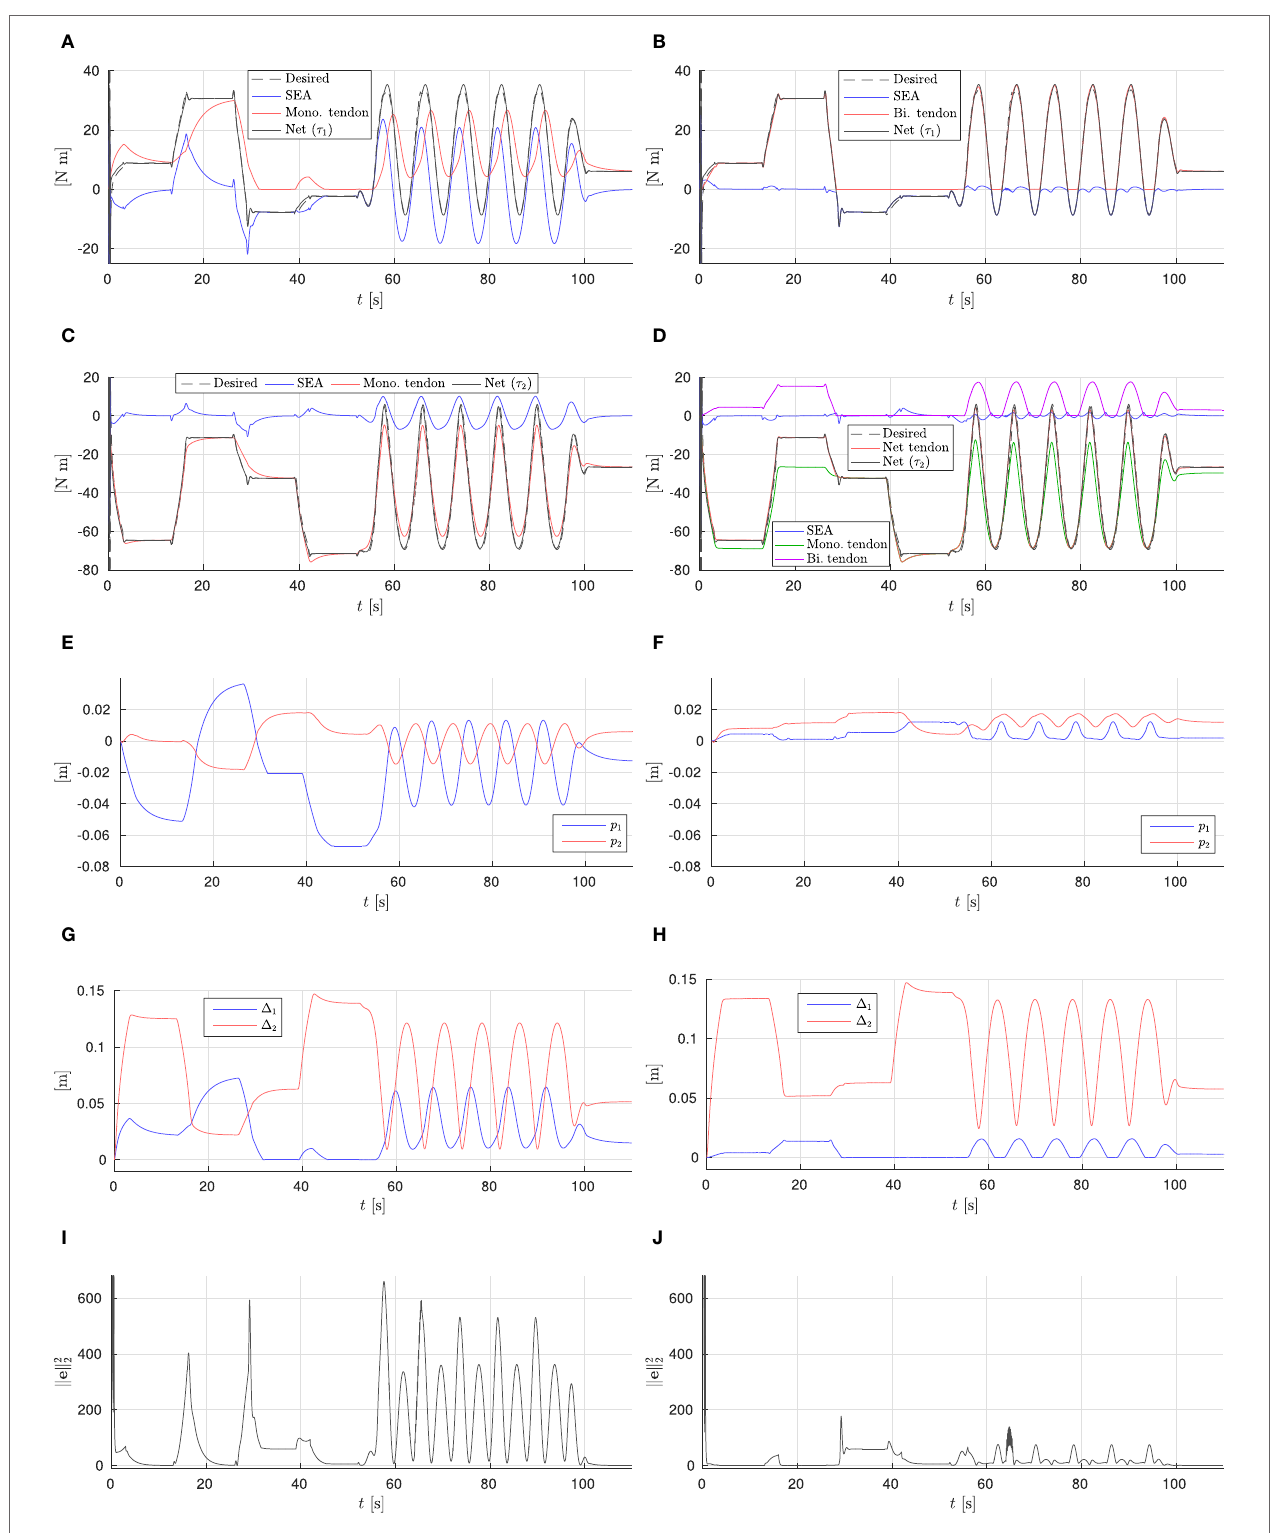
FIGURE 8 | Simulation results. (A) Monoarticulated: ankle (q1) torques. (B) Biarticulated: ankle (q1) torques. (C) Monoarticulated: knee (q2) torques. (D) Biarticulated: knee (q2) torques. (E) Monoarticulated: pretension positions. (F) Biarticulated: pretension positions. (G) Monoarticulated: elastic element elongation. (H) Biarticulated: elastic element elongation. (I) Monoarticulated: squared l2-norm of error. (J) Biarticulated: squared l2-norm of error.